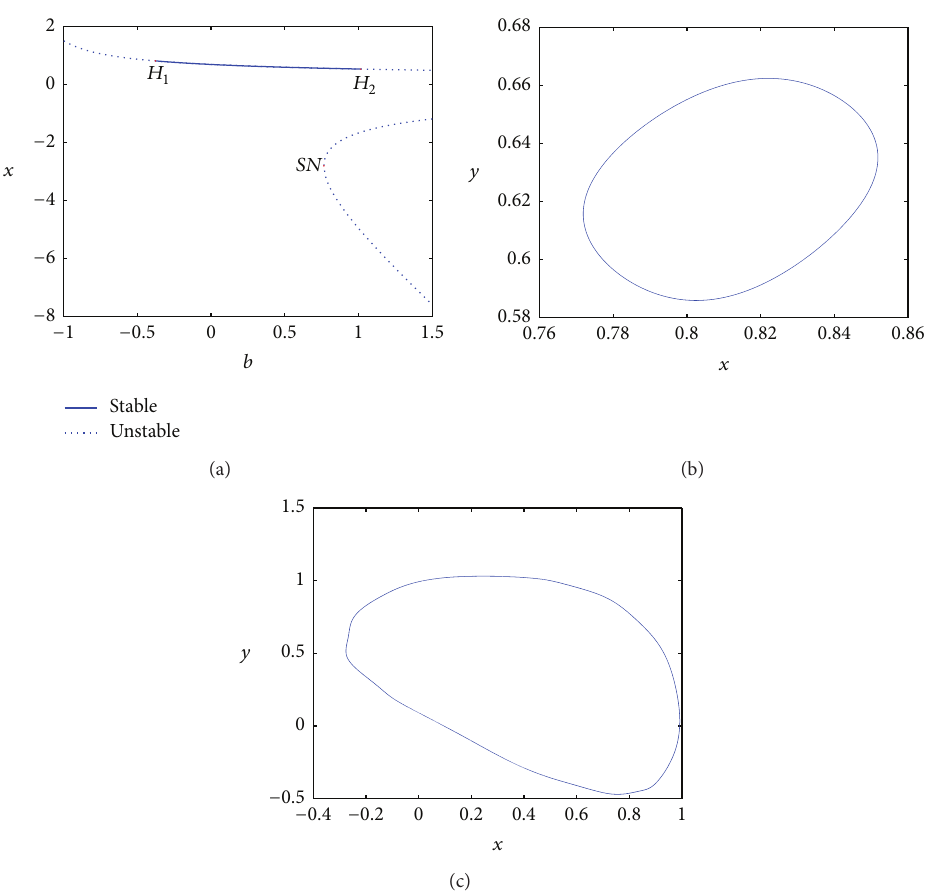
Figure 2: (a) Bifurcation diagram of the fixed points of map (2) in (𝑏, 𝑥) plane for 𝑎 = −0.1 , 𝑐 = −0.5 , 𝑑 = −0.5 , and 𝑒 = −0.3 ; (b) and (c): invariant cycles corresponding to Figure 2(a) at 𝑏 = −0.38 and 𝑏 = 1.02 , respectively.